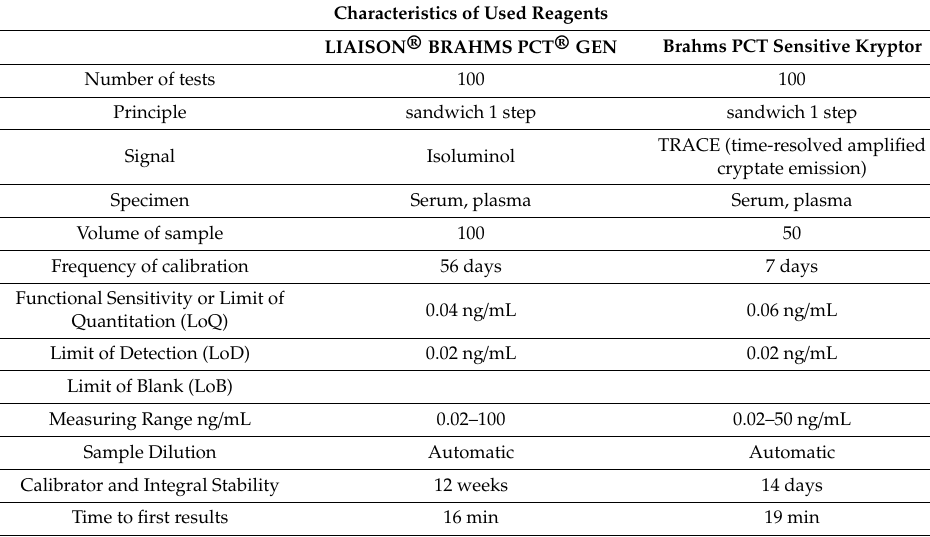
Table 2. Characteristics of used